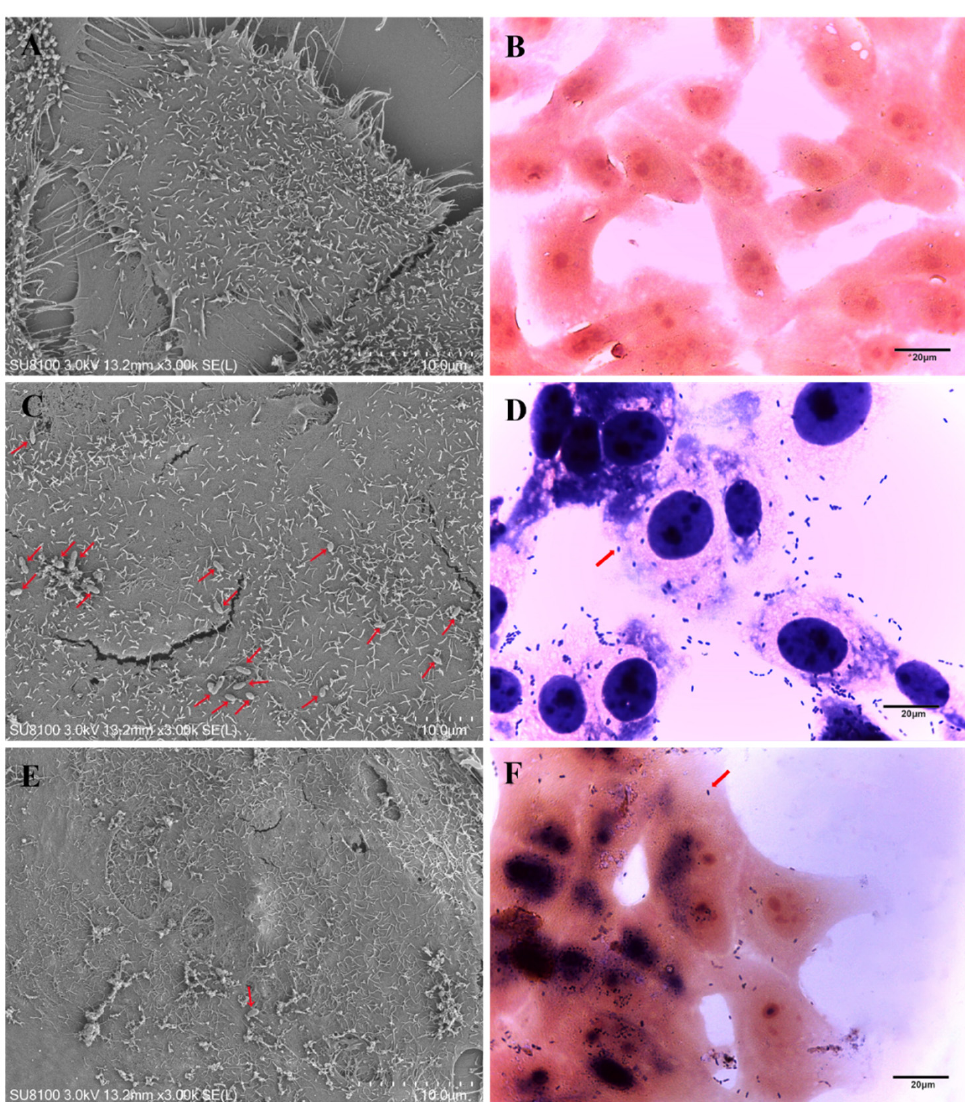
Figure 7. Image of morphology and structure of MAC-T observed by SEM, and the red arrow is bacteria. ( A ) Control group, ( C ) LG41 infection after 24 h, and ( E ) LG47 infection after 24 h. Gram staining image of morphology and structure of MAC-T; ( B ) control group, ( D ) LG41 infection after 24 h, and ( F ) LG47 infection after 24 h.